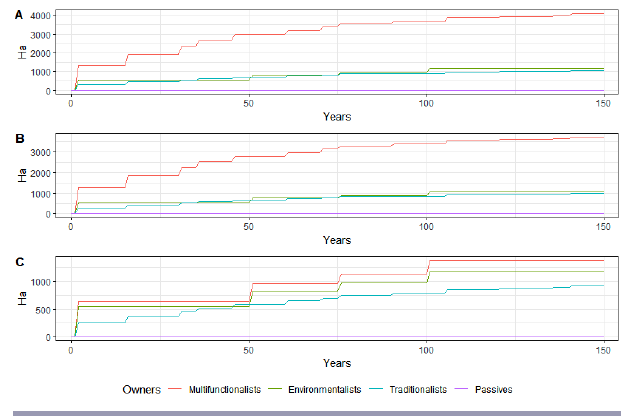
Fig. 4 . Management scenarios following policy design schemes (A-C), average of 100 runs.